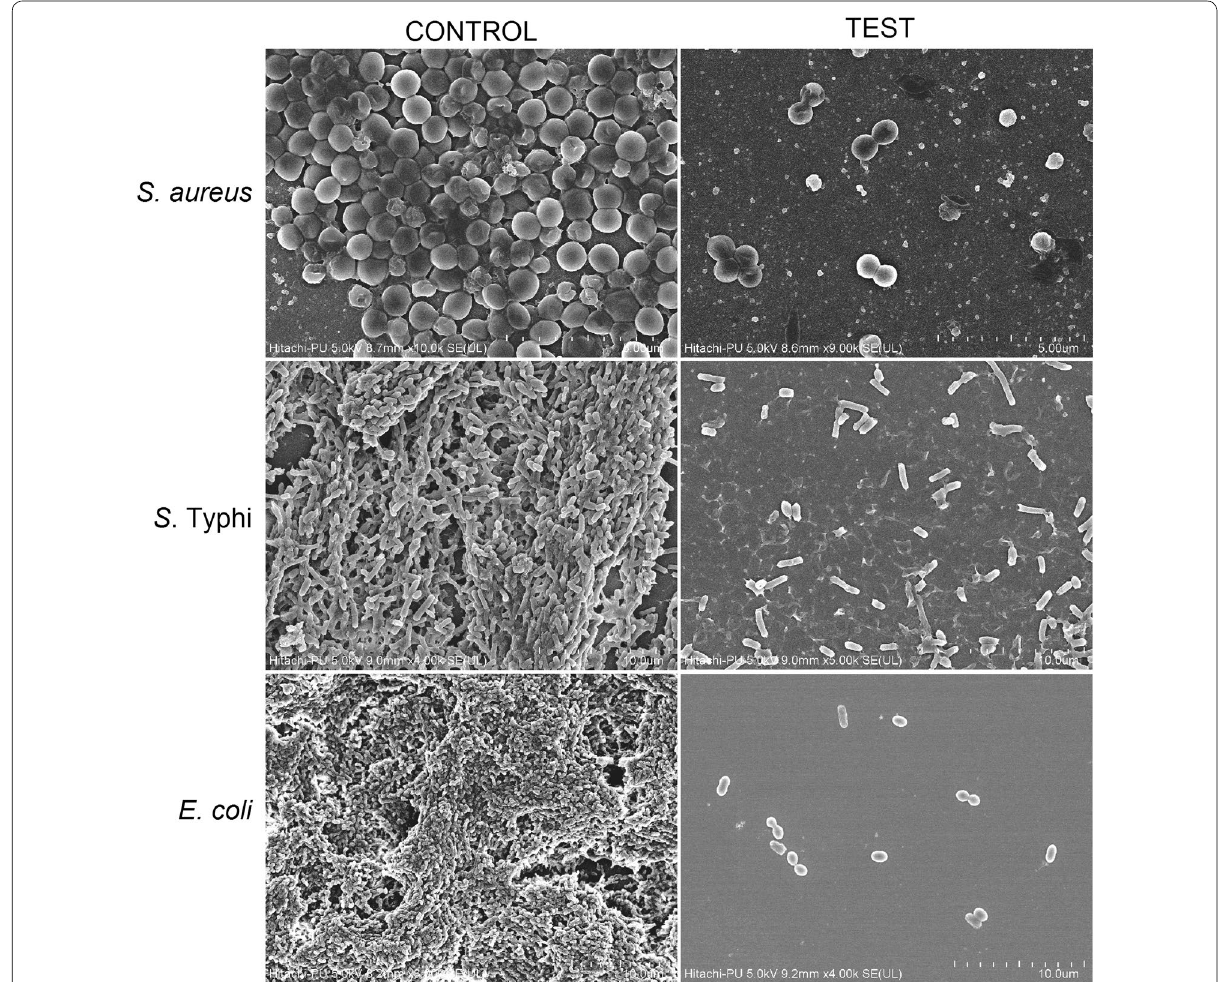
Fig. 3 FE-SEM images of the control (untreated) biofilms established on coverslips and test biofilms (treated with in-house produced